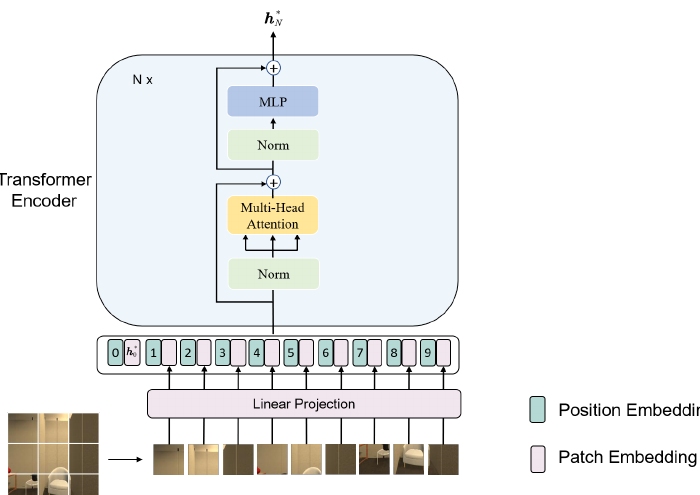
Figure 4. Network architecture of the ViT-based visual encoder.